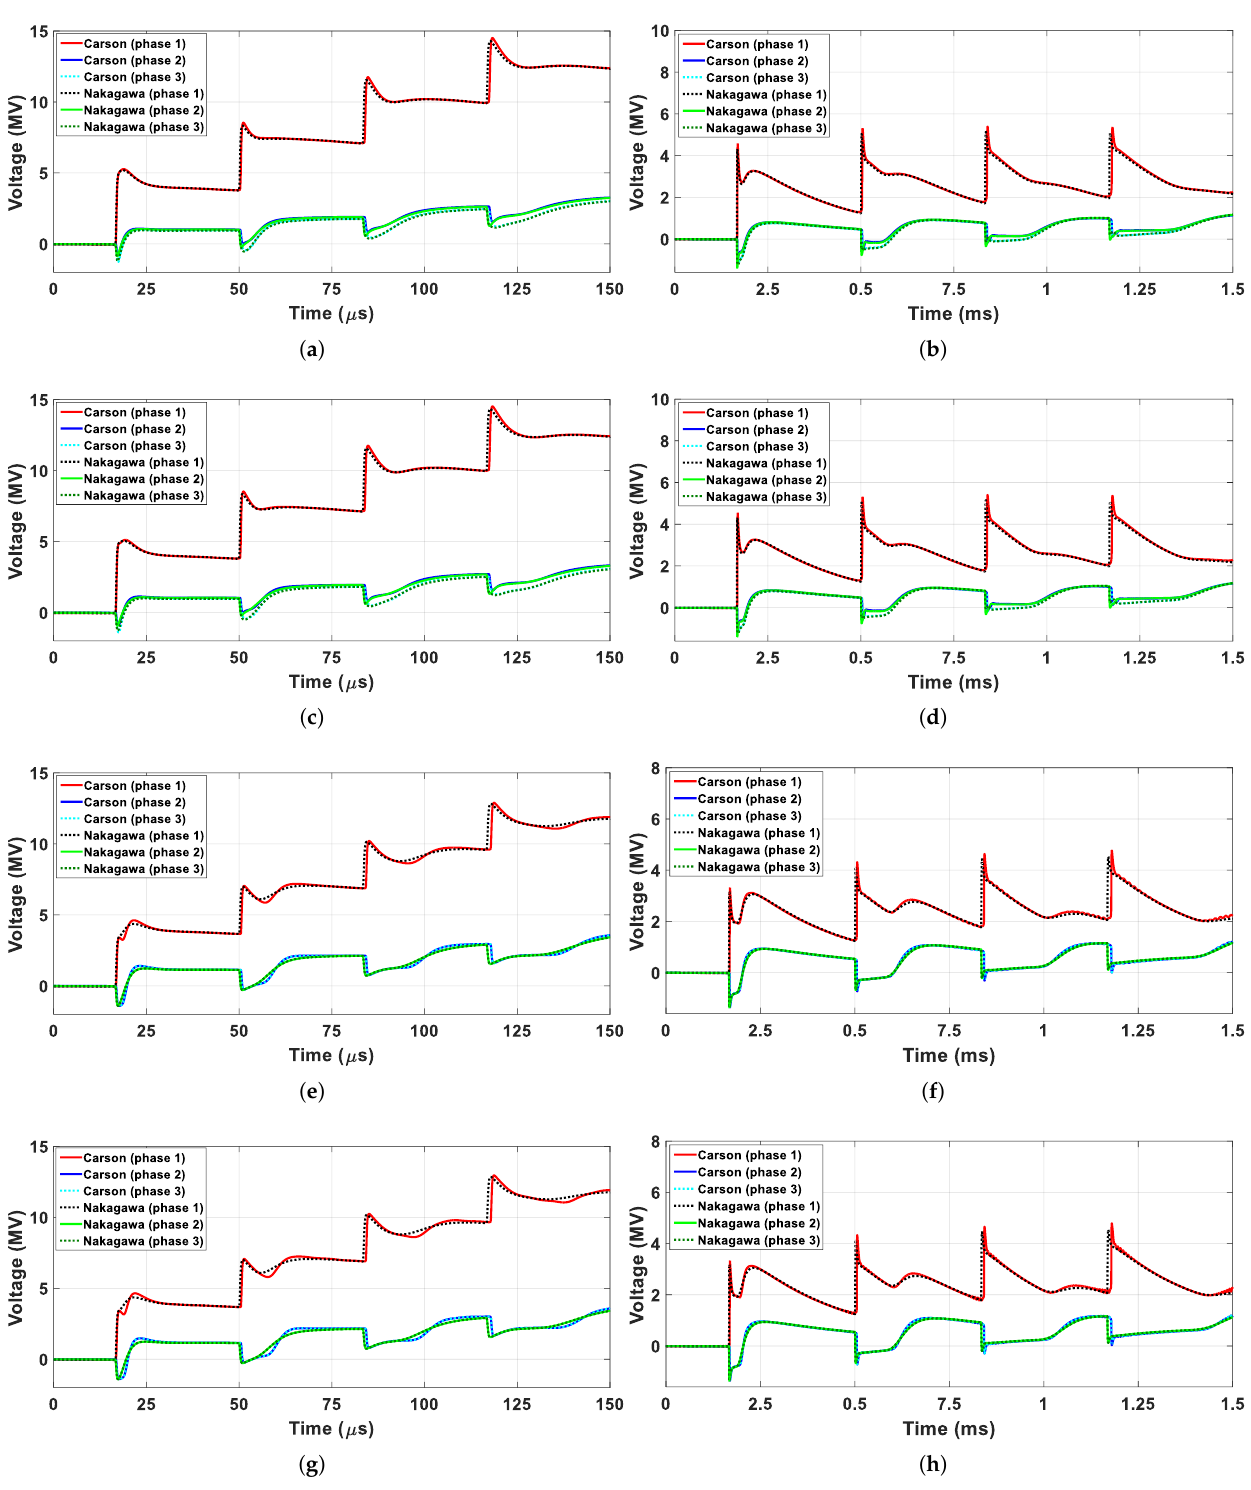
Figure 10. Transient voltages at the receiving end of the TL of Figure 9 when the current source is the subsequent stroke of Section 4.1, and the length of the line and soil resistivity are, respectively, ( a ) 5 km–500 Ω · m, ( b ) 50 km–500 Ω ·